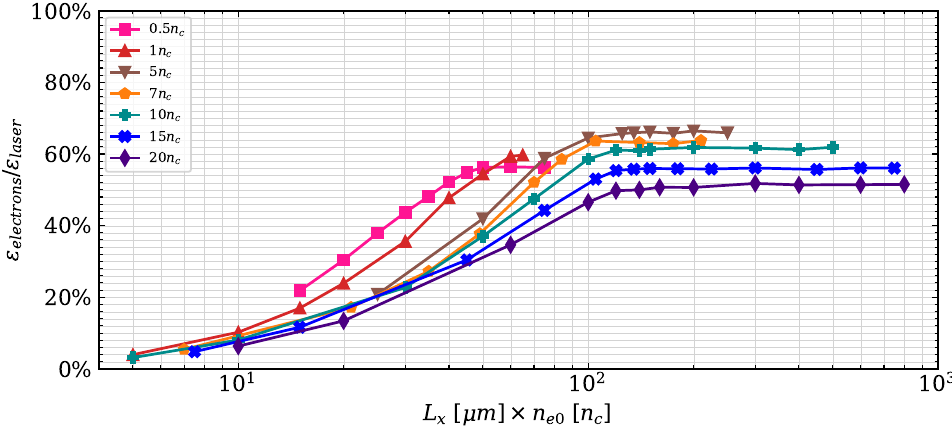
Figure 4. Energy conversion coefficient from the laser to electrons vs. target areal density as obtained in 2D PIC simulations. Target parameters: L y = 30 µ m. Laser parameters: λ = 1 µ m, a 0 = 85, τ = 20 fs FWHM and w 0 = 12.5 µ